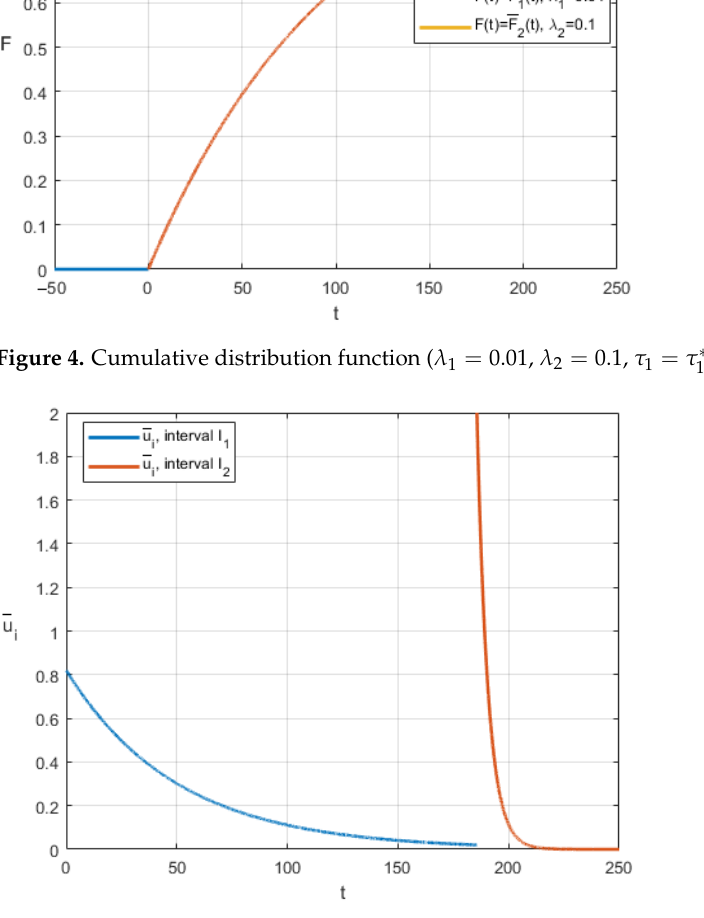
Figure 5. Optimal control for state-dependent case.